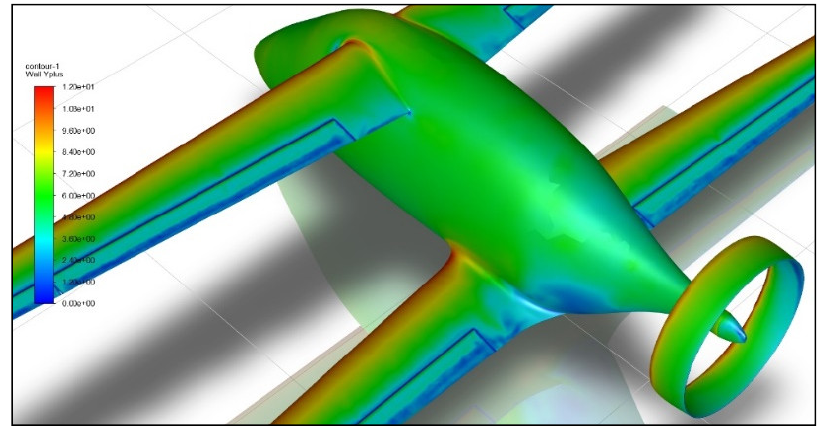
Figure 11. Prismatic boundary layer on both the fuselage and the duct surfaces.